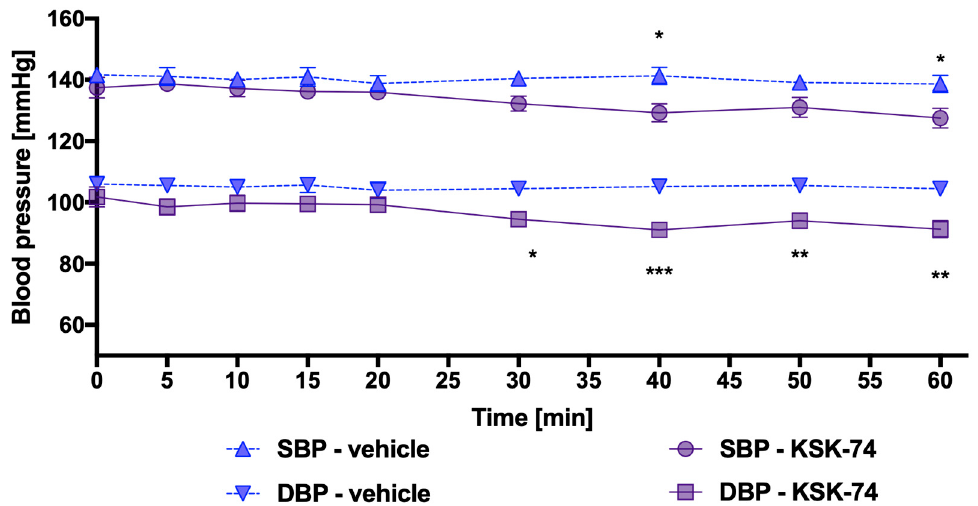
Figure 6. Effect of KSK-74 on blood pressure after a single administration (10 mg/kg i.p.). Results are presented as mean ± SEM, n = 6. Statistical analysis: two-way ANOVA with repeated measures, Bonferroni’s post hoc tests, * p < 0.05; ** p < 0.01; *** p < 0.001 vs. vehicle group. SBP—systolic blood pressure; DBS—diastolic blood pressure.